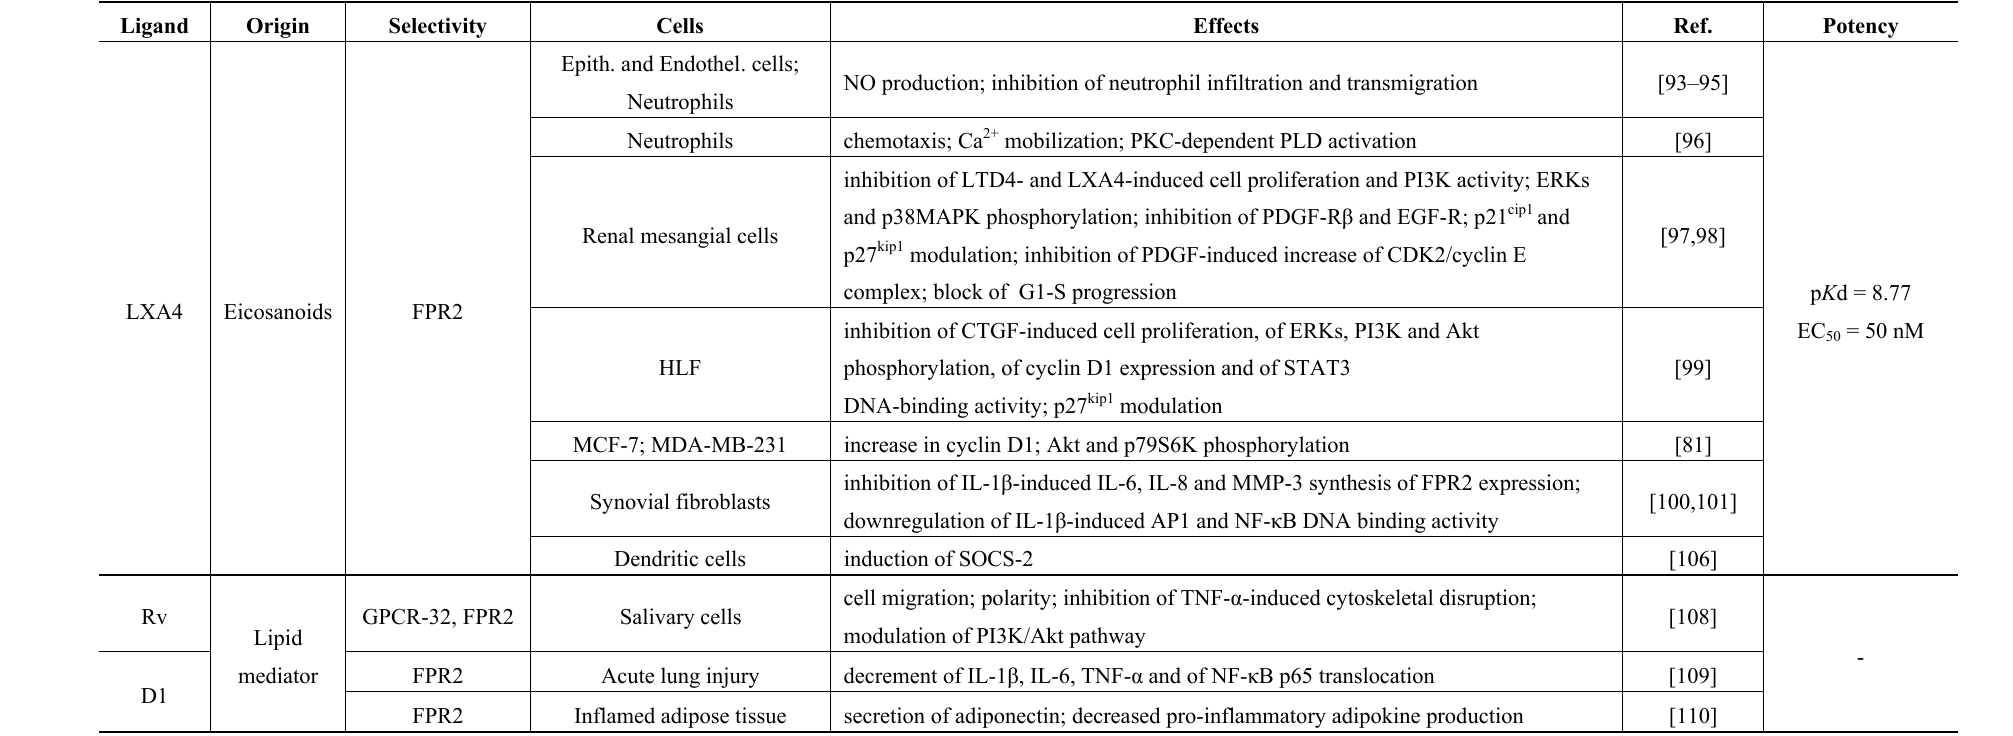
Table 7. Intracellular signaling cascades triggered by endogenous nonpeptide